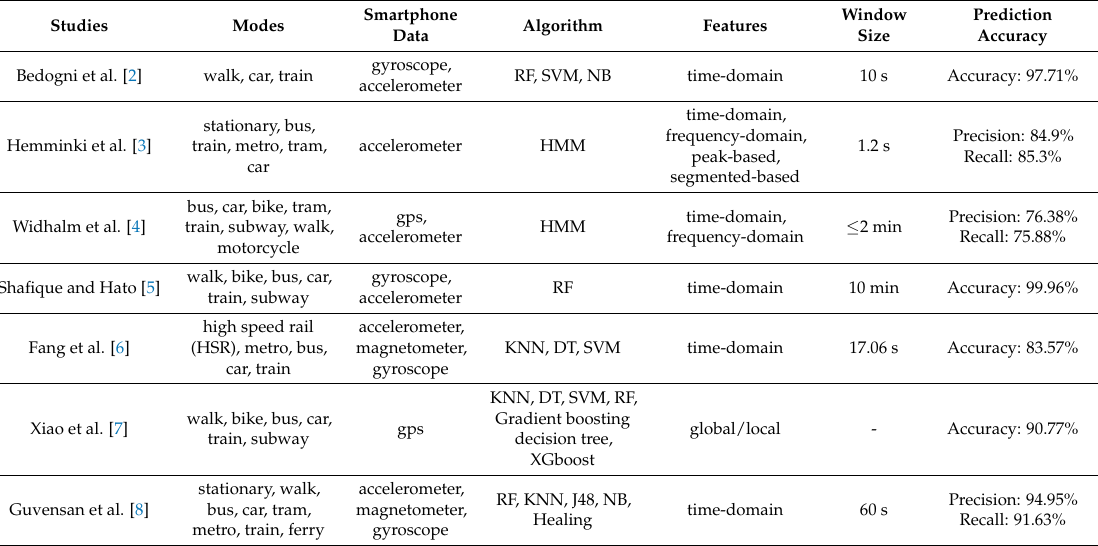
Table 1. Summary of recent researches on vehicle mode detection.